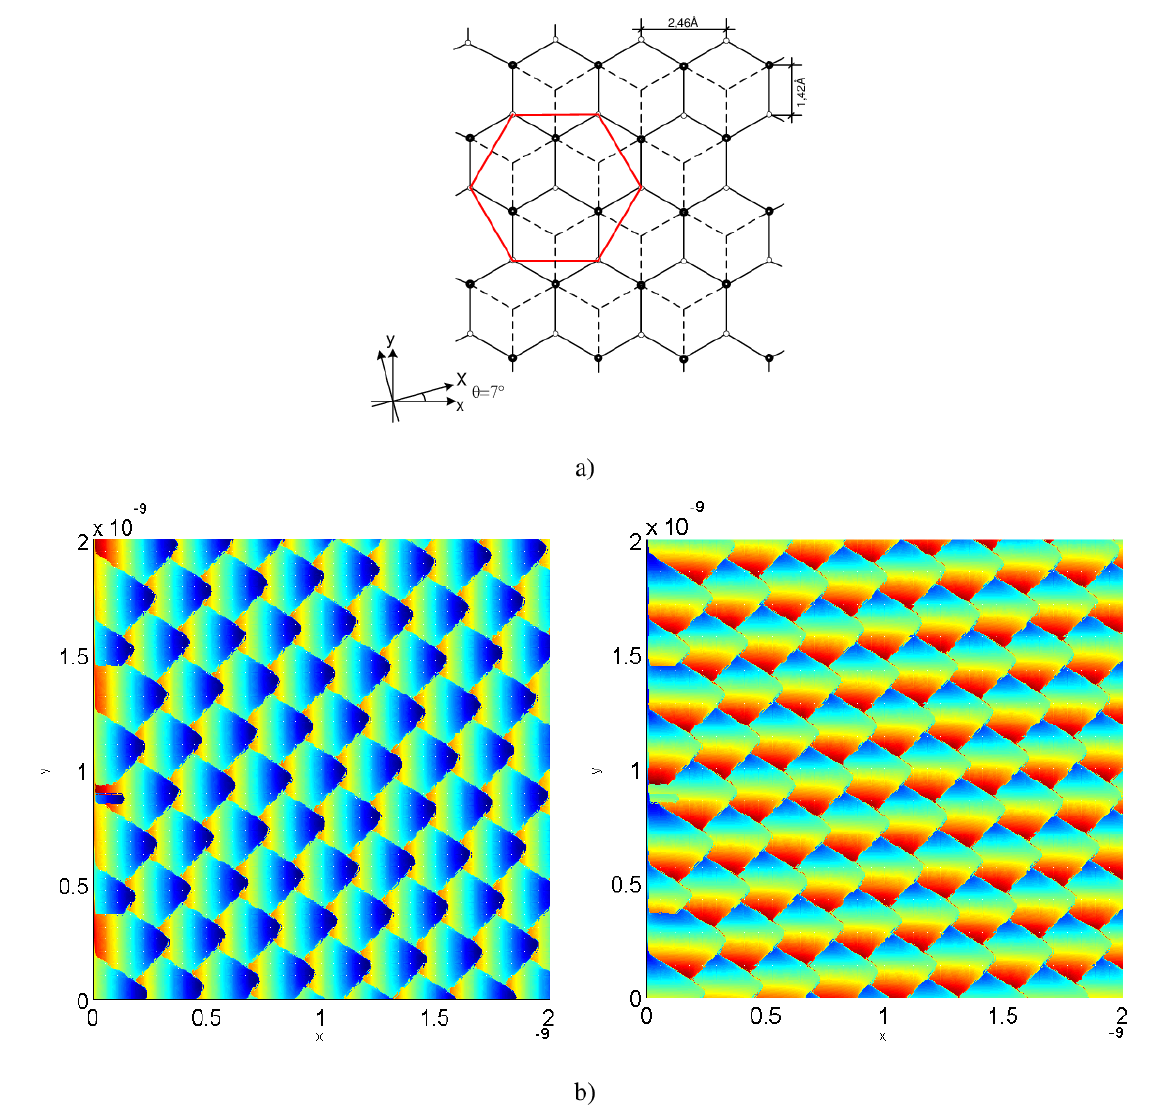
Figure 8 a) Position of the atoms in the HOPG crystal net; b) Elastic force in the tip: F x in the left hand side and F y in the right hand